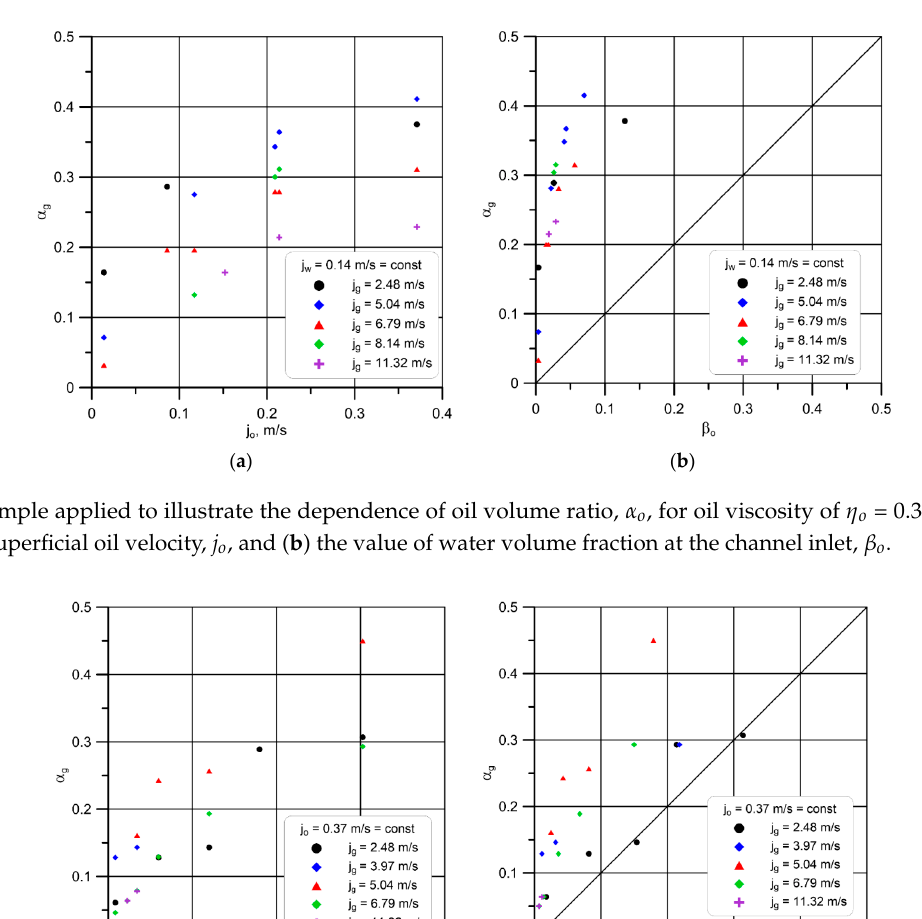
Figure 4. Gas void fraction α g (oil viscosity η o = 0.3 Pas) in the function of ( a ) superficial gas velocity, j g , and ( b ) value of gas void fraction at the channel inlet, β g .